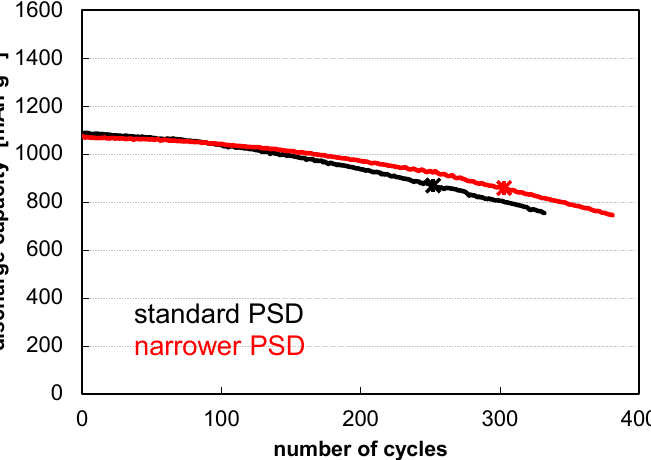
Figure 3. Cycling behavior of full cells (discharge capacity of anode active material) based on air classified (narrower) CLM00001 compared to unmodified (standard) CLM00001 in the 4.2–3.0 V range. The asterisks mark 80% capacity retention. The removal of fine particles moderately increases